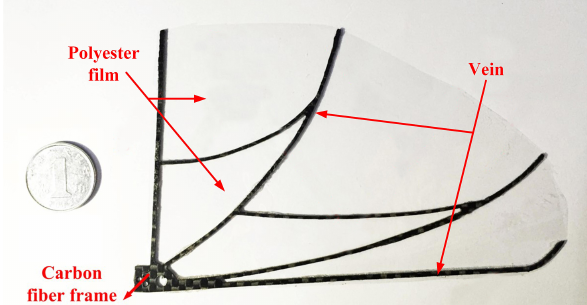
Figure 9. Photograph of wing A with the carbon fiber board thick- ness of